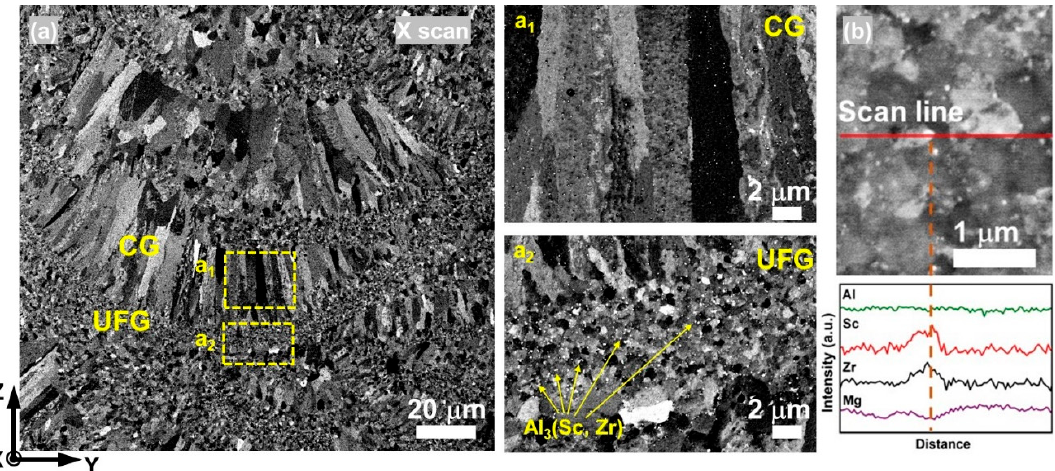
Figure 6. BSE images of ( a ) the YZ plane of the X-scan sample with the high-magnification images of ( a1 ) CG and ( a2 ) UFG regions, with corresponding ( b ) EDS element line analysis profiles of the precipitation.